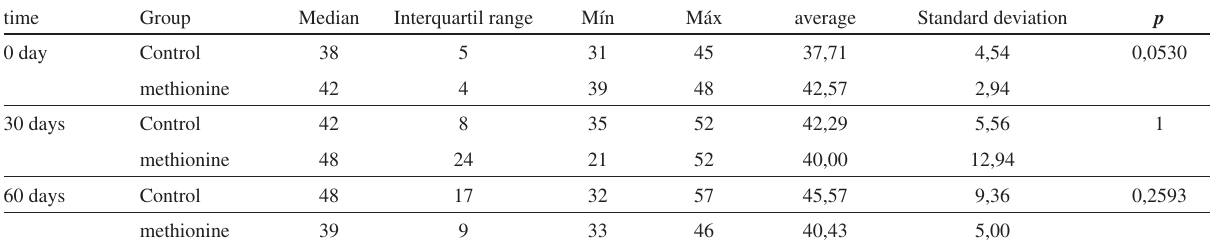
Table 3 - HDL levels (mg/dl)